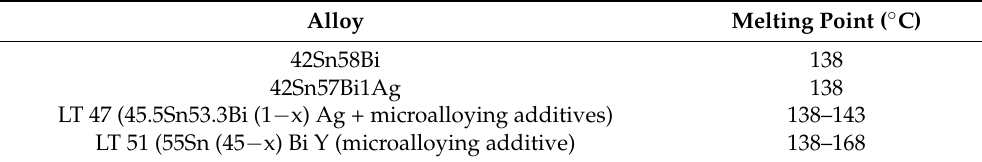
Table 1. Tin–bismuth alloys under investigation.